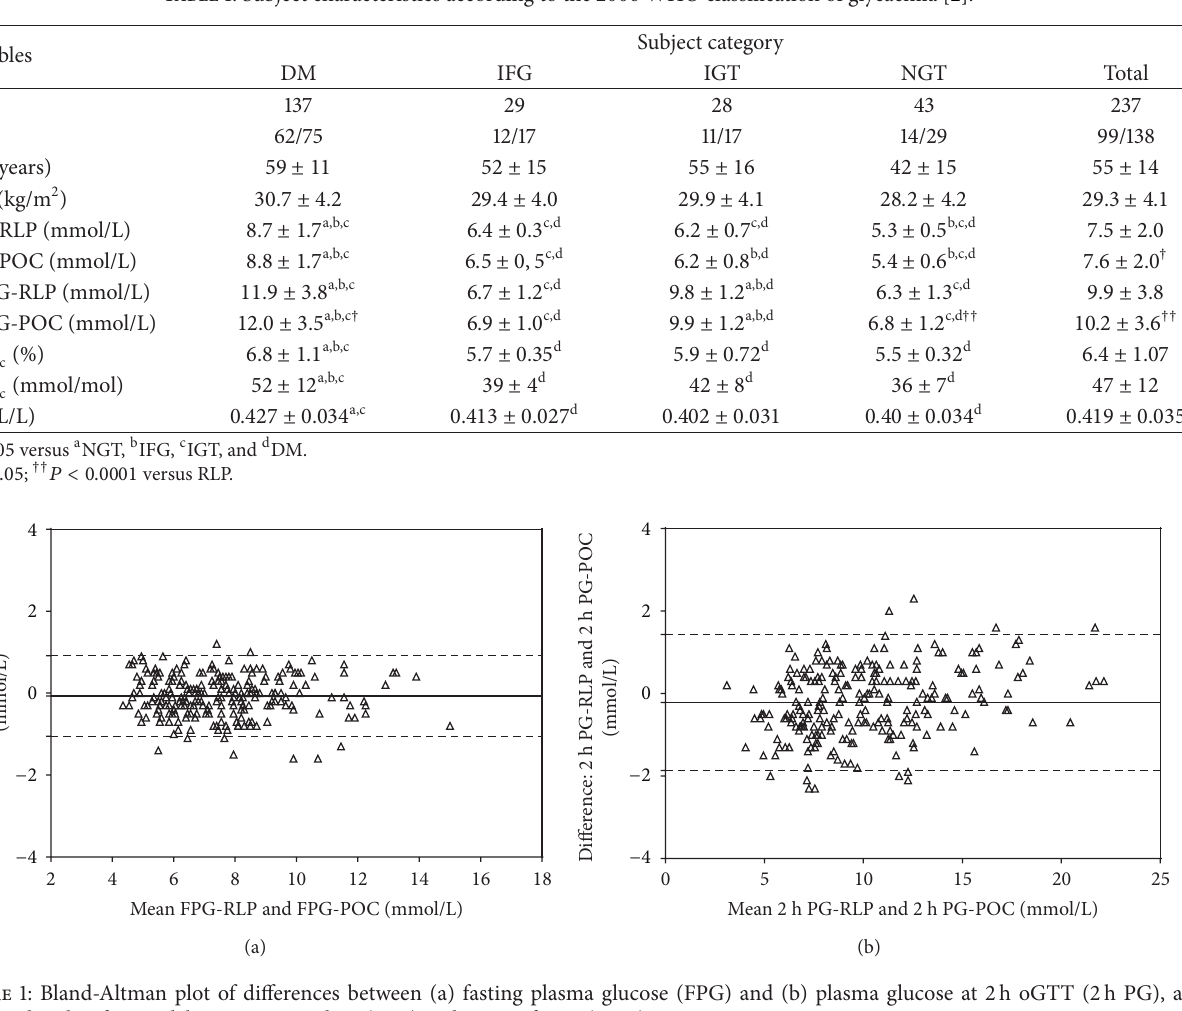
Figure 1: Bland-Altman plot of differences between (a) fasting plasma glucose (FPG) and (b) plasma glucose at 2h oGTT (2h PG), as measured with reference laboratory procedure (RLP) and point-of-care (POC)